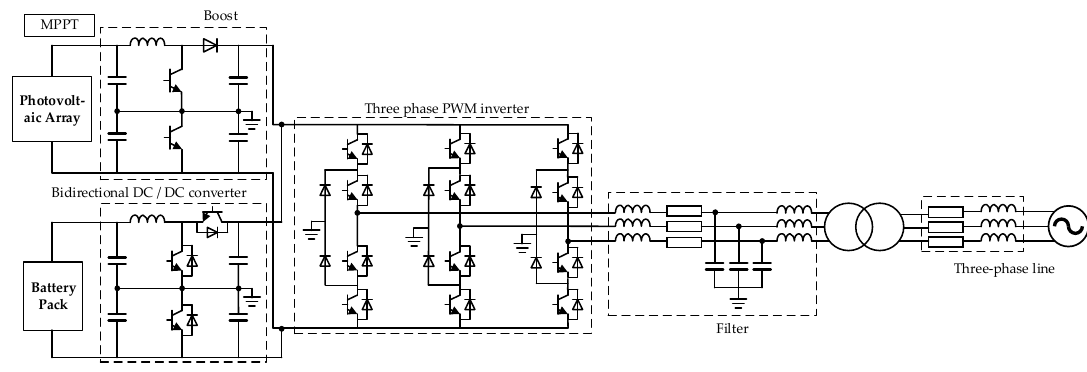
Figure 13. Configuration of the photovoltaic-battery hybrid generation system.